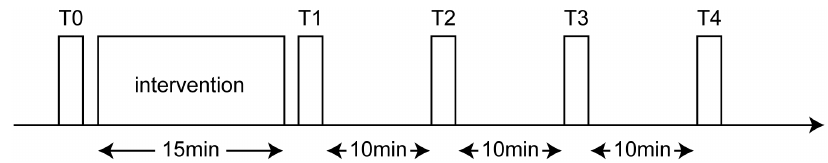
Figure 1. The experimental sequence used in the present study.